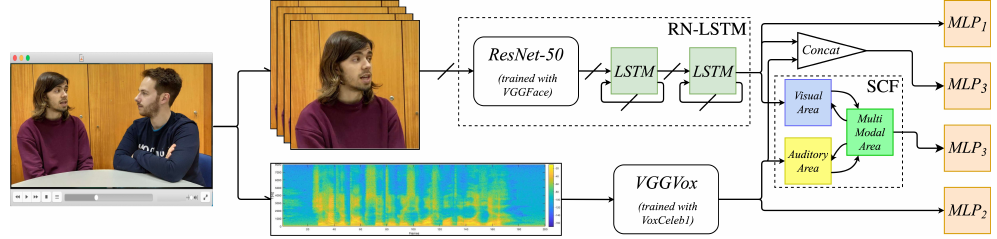
Figure 3. Structure overview of the proposed model. From a video, the image sequence of a face is extracted as well as the corresponding audio. A narrowband spectrogram is generated from the audio and progressed through VGGVox. The image sequence is progressed through the RN-LSTM without any preprocessing. The obtained audio and visual embeddings are then classified either separately or merged by concatenation or the SCF